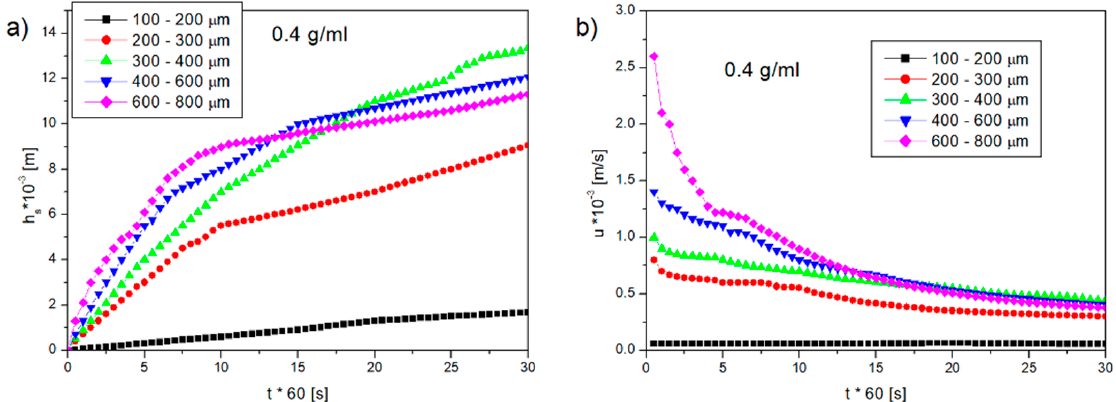
Figure 7. Dependence of ( a ) sediment layer height and ( b ) sedimentation velocity during the process for the sedimentation of microspheres with a concentration of 0.4 g/mL in an 70% emulsion, d e1 .